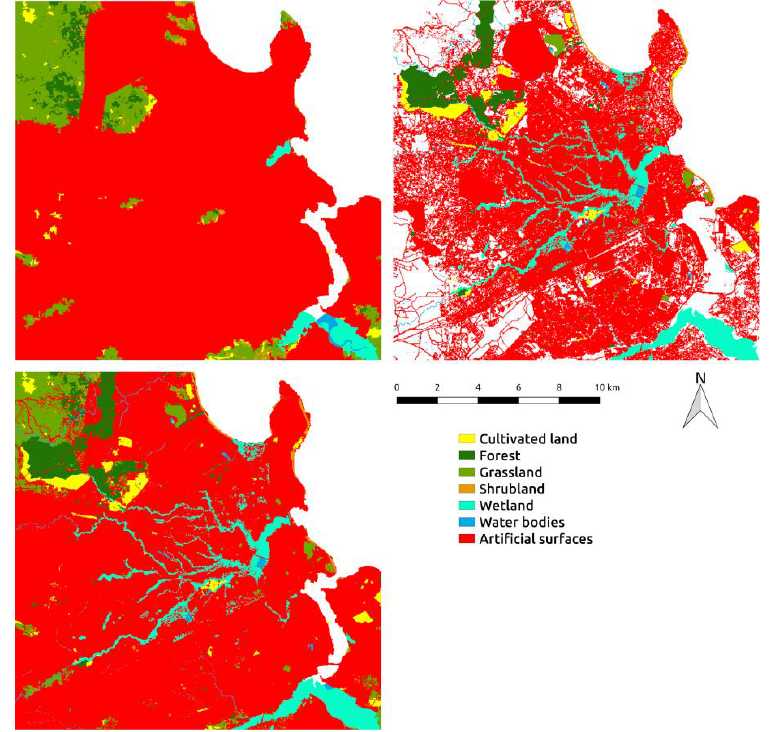
Figure 6. Original GL30 ( upper left ), OSM-derived LULC map ( upper right ) and updated GL30 ( lower left ) for the Dar es Salaam study area.